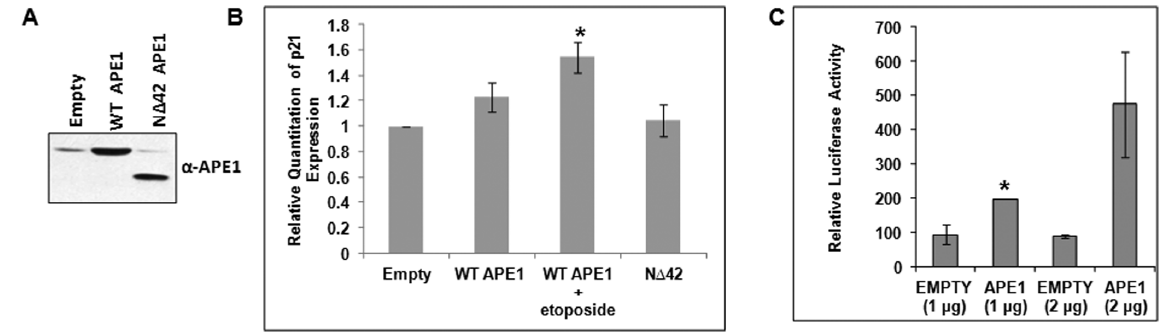
Figure 2. Effect of APE1 on p21 activation in p53 WT cells. ( A ) Western analysis for APE1 level in WT APE1 and N D 42 APE1 overexpressing cells. ( B ) Real Time RT-PCR analysis showing relative quantitation of p21 transcript level in etoposide-treated WT APE1-overexpressing HCT116 WT cells and N D 42 APE1 overexpressing cells; *: p value , 0.05 (n=2) calculated from control (empty vector transfection) vs. WT APE1 overexpression, WT APE1 overexpression along with etoposide treatment or N D 42 overexpression. ( C ) Luciferase activity in cells co-transfected with empty or WT APE1- expression vector and p21 promoter-luciferase construct; *: p value , 0.05 (n=2) calculated from control (empty vector transfection) vs. APE1